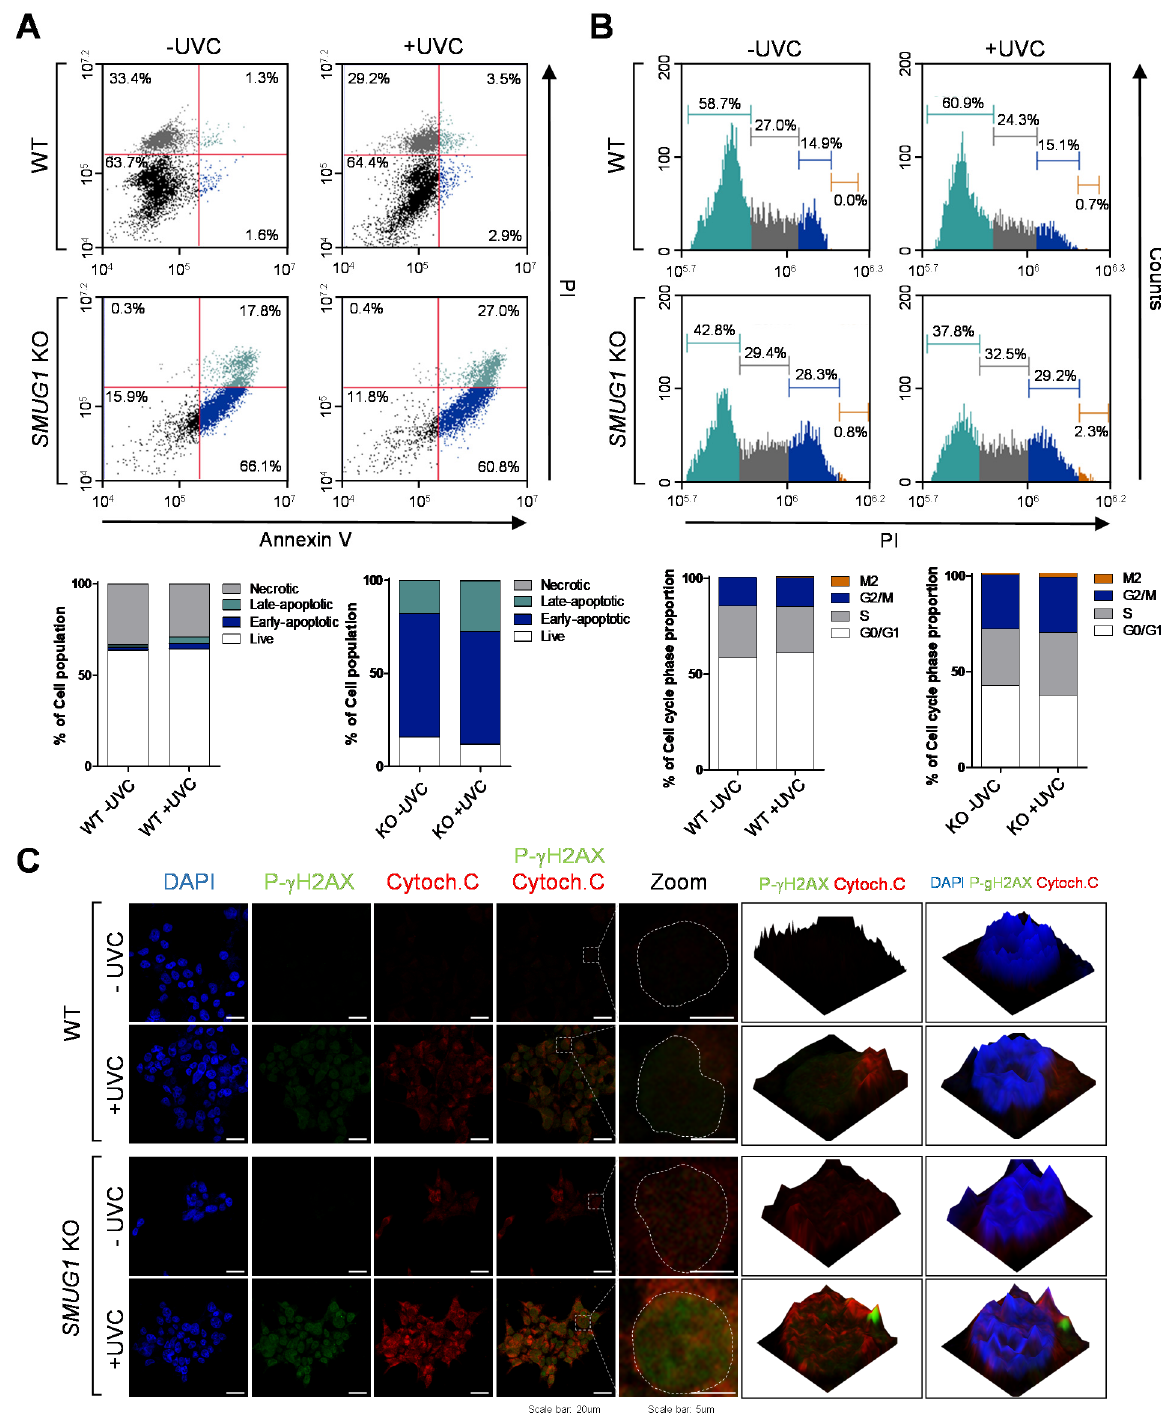
Figure 7. SMUG1 ablation accelerated UVC irradiation–mediated apoptosis. ( A ) Apoptosis of HepG2 WT and SMUG1 KO cells irradiated to UVC of 125 mJ/cm 2 and incubated for 24 h was tested by flow cytometry. Cells were stained with Annexin V-FITC and propidium iodide (PI). Representative scatter plots of PI (Y-axis) vs. Annexin V-FITC (X-axis). Values are the percentage of cells in the live, early, and late apoptosis and necrosis. ( B ) Flow cytometry analysis of cell cycle subversion in UVC-irradiated or non-irradiated WT and KO cells. Cells were fixed in ethanol at 24 h post-infection and stained with PI and applied to flow cytometry. ( C ) HepG2 WT and SMUG1 KO cells were irradiated with UVC and immunostained with anti-phospho-gamma-H2AX (green) and cytochrome c (red) antibodies. The cell nuclei were stained with DAPI (blue).